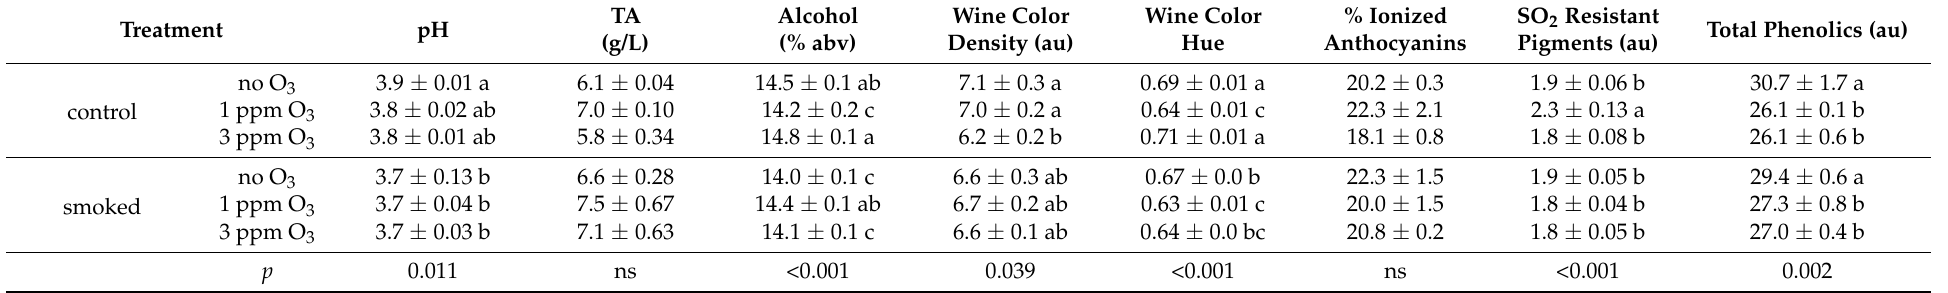
Table 2. Basic composition of wines made from control and smoke-affected grapes, with and without post-harvest ozone treatment (at 1 ppm for 24 h or 3 ppm for 12 h). Treatment